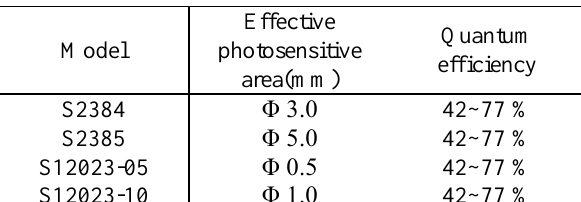
Table 2. Typical characteristics of APD in blue-green